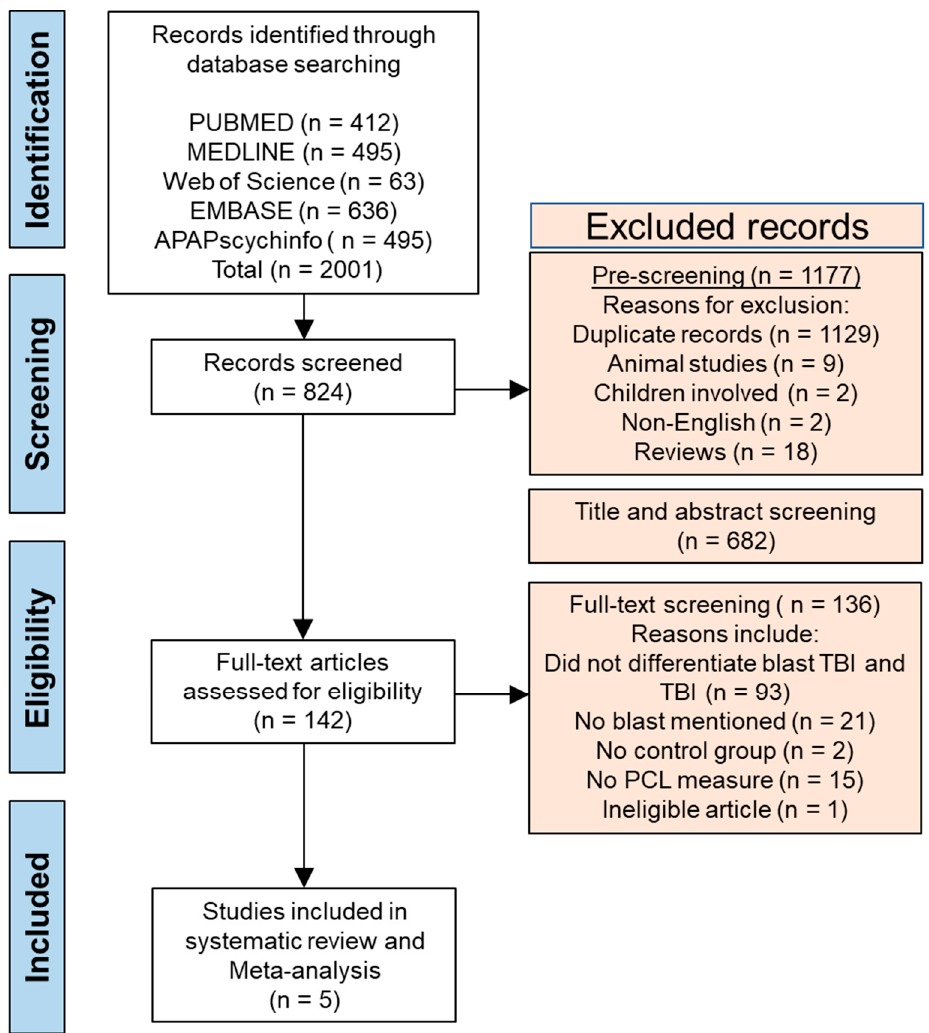
Figure 1. PRISMA flow chart.